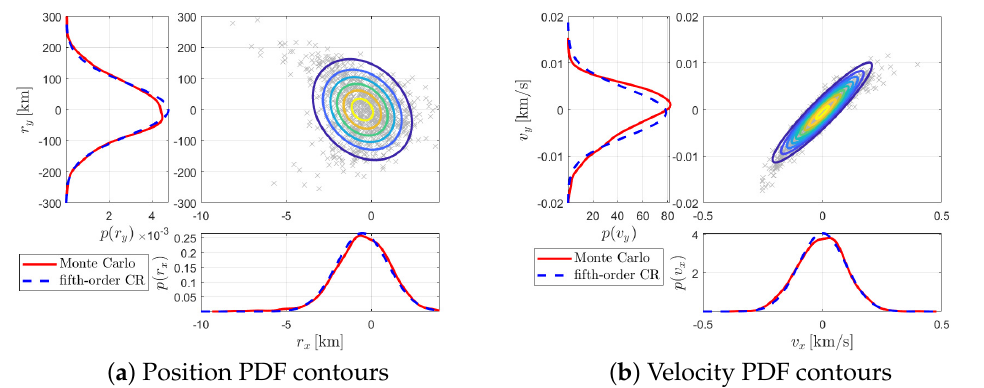
Figure 7. PDF contours using fifth-order CR with Monte Carlo samples of LEO